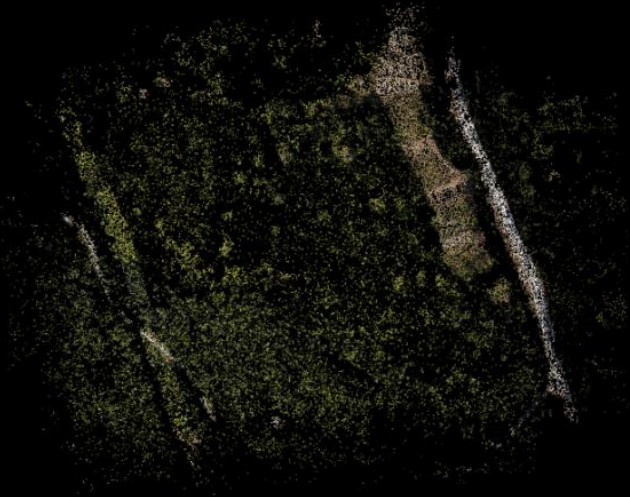
Figure 4. Homologous point matching